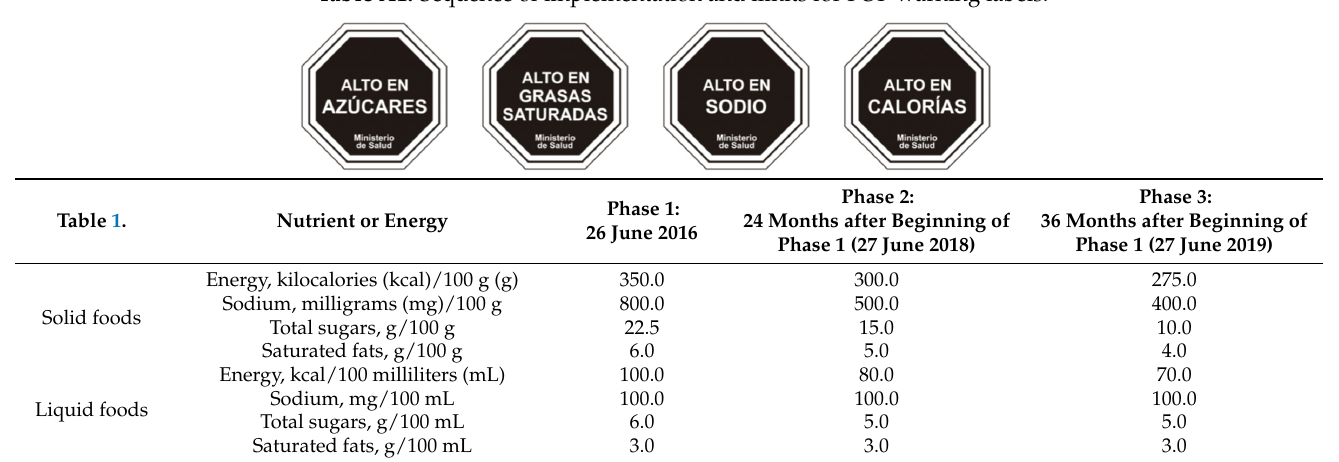
Table A1. Sequence of implementation and limits for FOP warning labels.